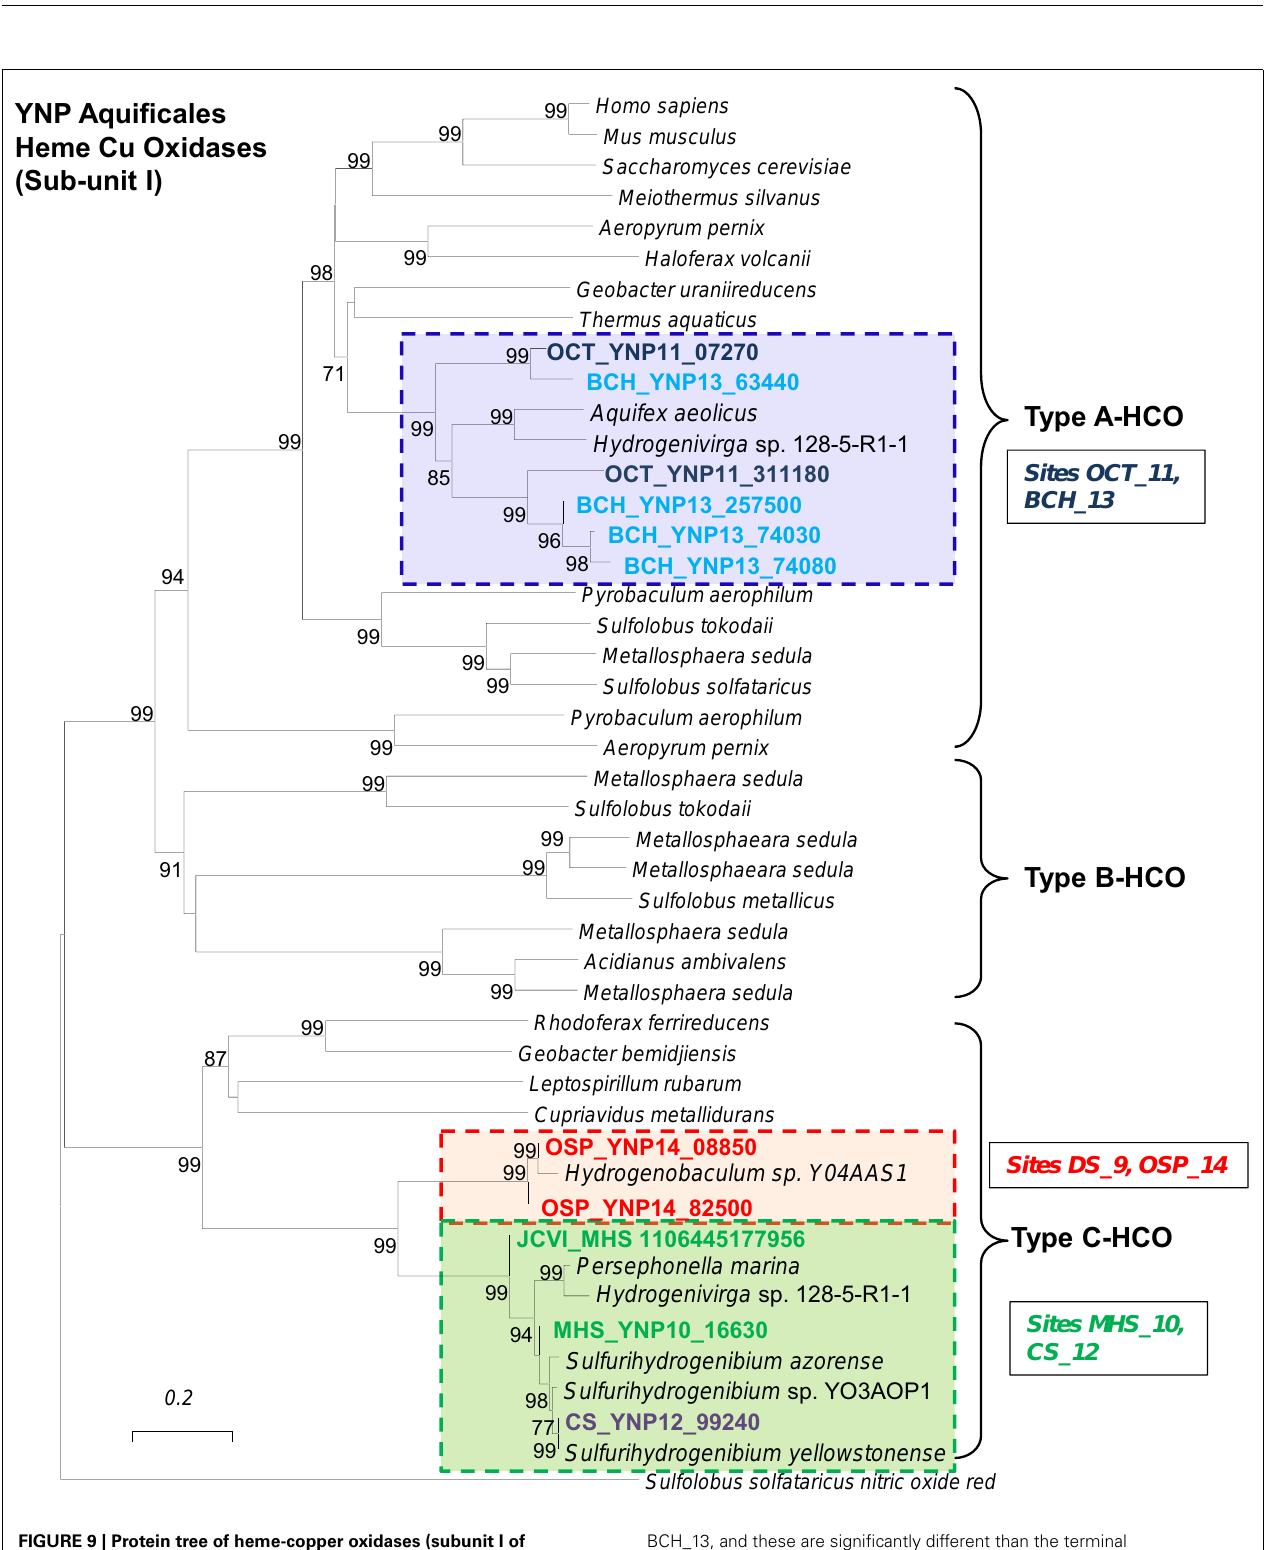
FIGURE 9 | Protein tree of heme-copper oxidases (subunit I of terminal oxidase complex) . Metagenome entries are highlighted by site, and labels correspond to the major types of heme-copper oxidases observed in different Aquificales “streamer” communities. Similar heme-copper oxidases are found in sites OS_11 and